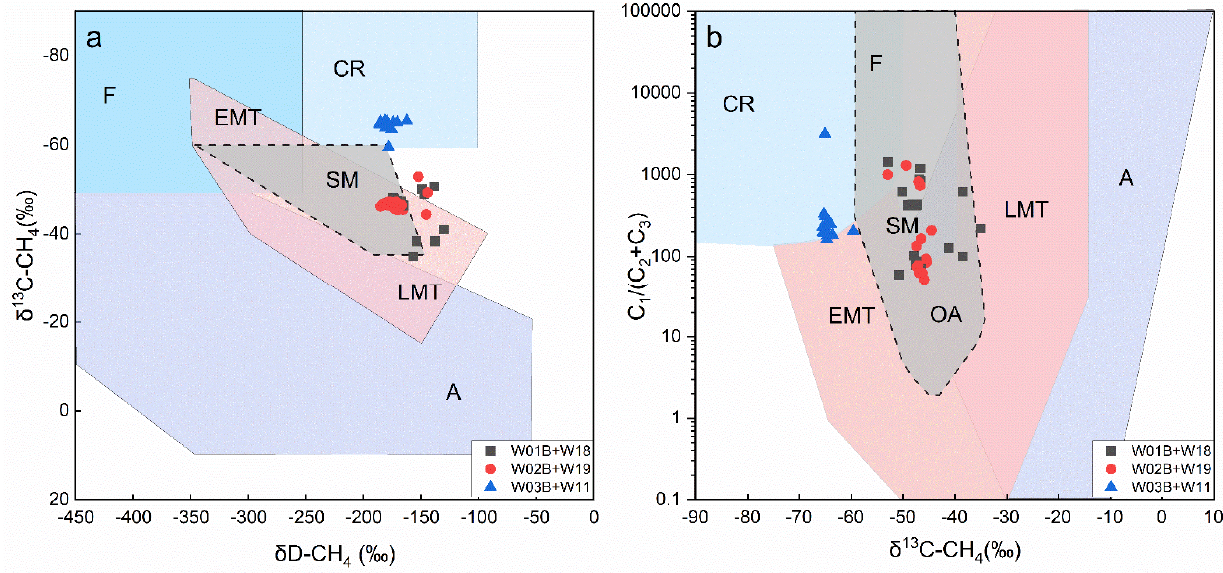
Figure 9. Genetic diagram of ( a ) δ D-CH 4 versus δ 13 C-CH 4 and ( b ) C 1 /(C 2 + C 3 ) versus δ 13 C-CH 4 (the boundary lines are from [130]), showing the genetic type of the hydrate-related gas from sites W01B, W02B, and W03B. Data from [19–22]. A—abiotic; F—fermentation; CR—CO2 reduction; EMT—early-mature thermogenic; LMT—late-mature thermogenic; SM—secondary microbial.